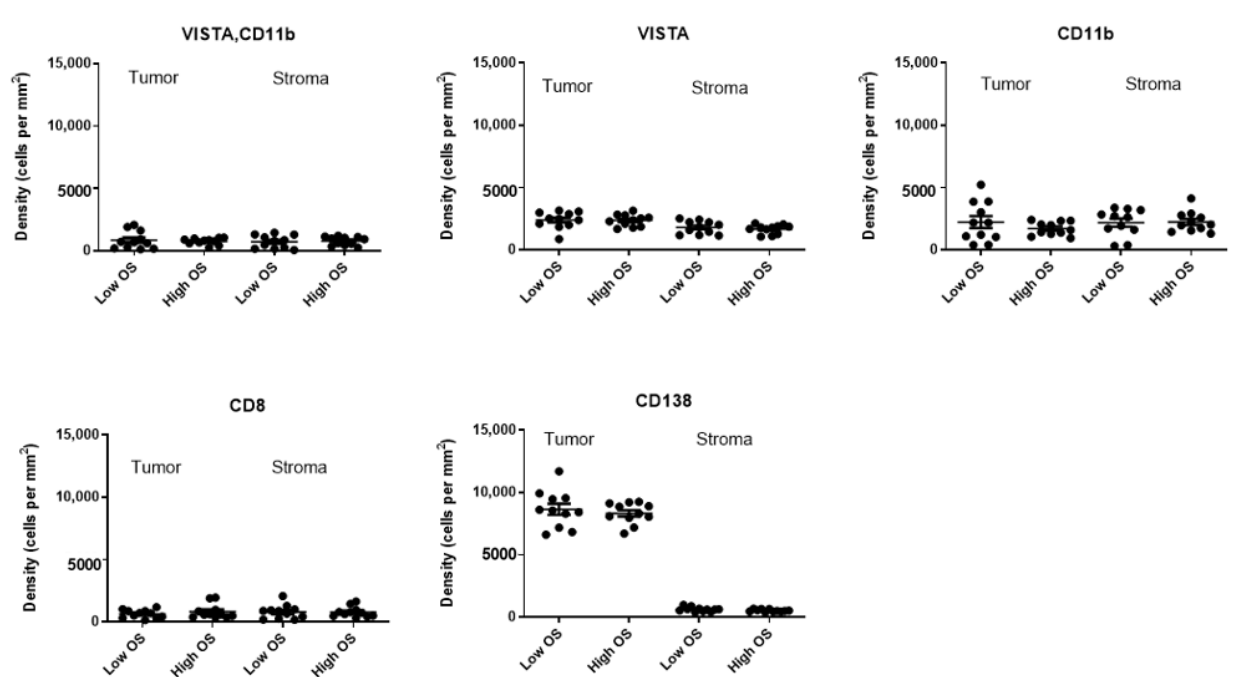
Figure 4. Densities of immune cells, including VISTA+, CD11b+ cells, do not differ between MM patients with low and high OS. Scatter plots of densities of cells (y-axis) in tumoral and stromal compartments of bone marrows from patients ( n = 22) with low versus high OS. OS was separated according to median value; and lines indicate mean +/ − SEM densities .